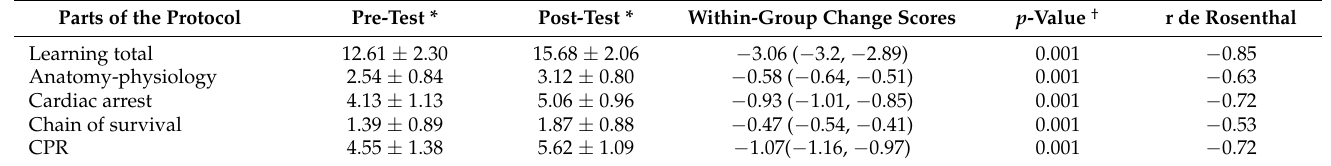
Table 1. Description of pre- and post-test scores by parts of the protocol.